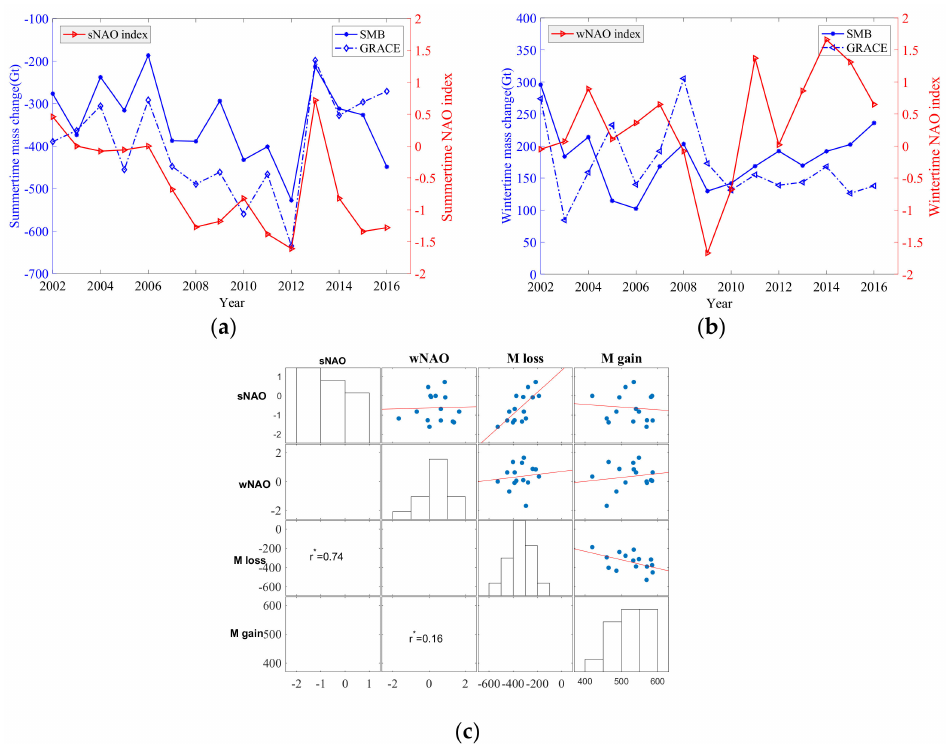
Figure6. InterannualmasschangesfromGRACEcomparedwiththe( a )summertime(June-July-August) NAO index (sNAO) and ( b ) wintertime (December-January-February) NAO index (wNAO). ( c ) The correlation of the NAO index and mass changes inferred from GRACE. The M_loss is the summertime mass loss from GRACE, and the M_gain is the wintertime mass gain from GRACE (the correlations r ∗ are computed at the 95% confidence levels, p < 0.05).